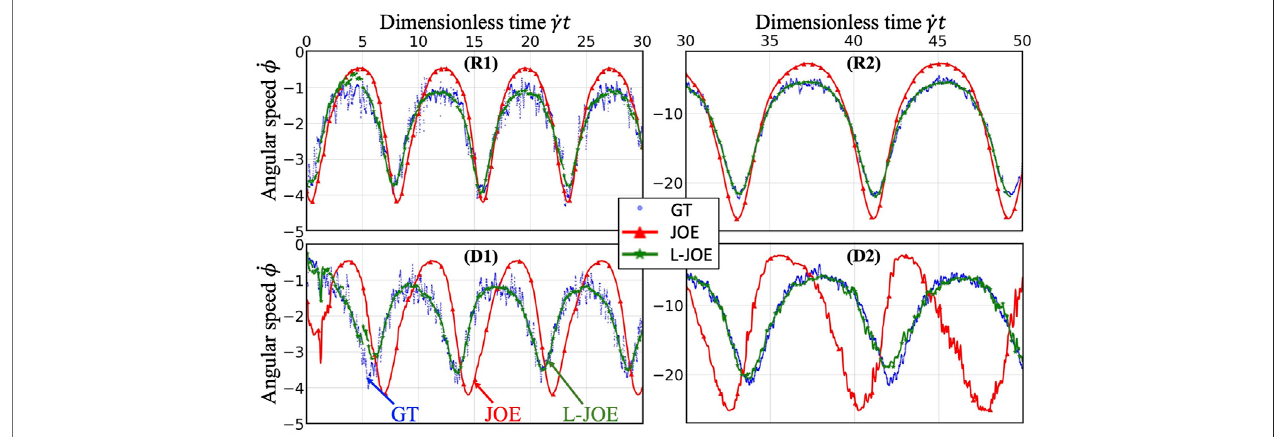
FIGURE 11 | Online learning predictions of angular speed _ ϕ for each step, taking examples from rigid and deformable platelets at 50 dyne/cm 2 (R1, D1) and 300 dyne/cm 2 (R2, D2) .